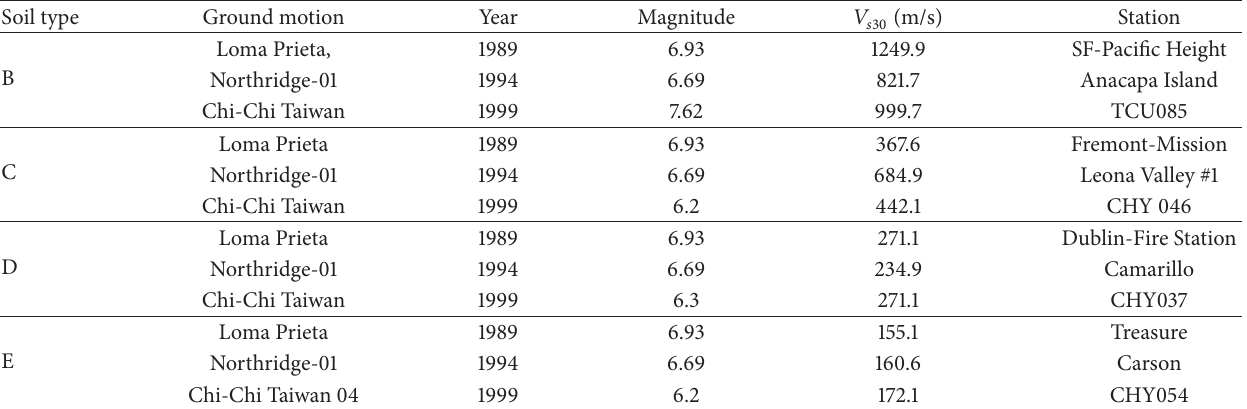
Table 10: Earthquake records used in the comparative